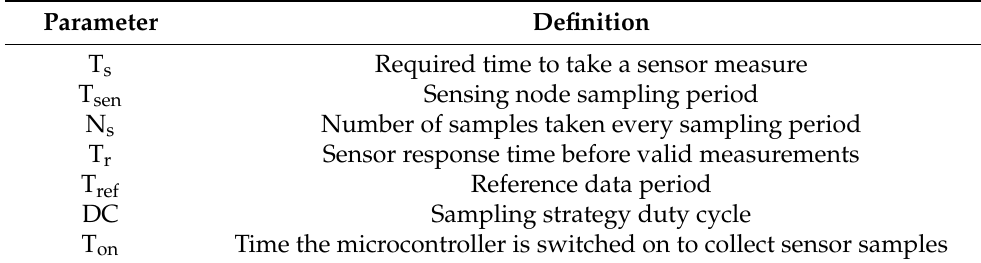
Table 3. Sensor sampling